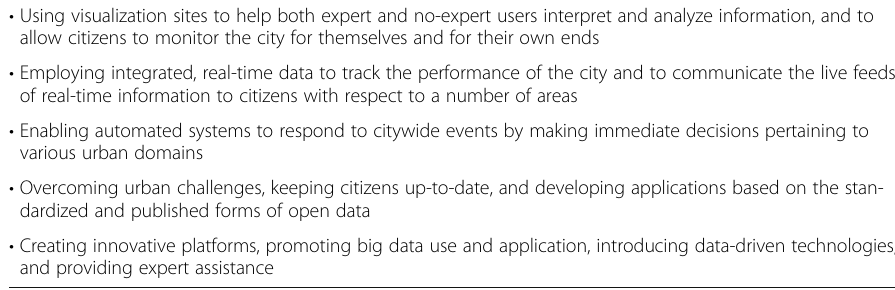
Table 9 The key functions of operations centers and dashboards (cid:129) Using visualization sites to help both expert and no-expert users interpret and analyze information, and to allow citizens to monitor the city for themselves and for their own ends (cid:129) Employing integrated, real-time data to track the performance of the city and to communicate the live feeds of real-time information to citizens with respect to a number of areas (cid:129) Enabling automated systems to respond to citywide events by making immediate decisions pertaining to various urban domains (cid:129) Overcoming urban challenges, keeping citizens up-to-date, and developing applications based on the stan- dardized and published forms of open data